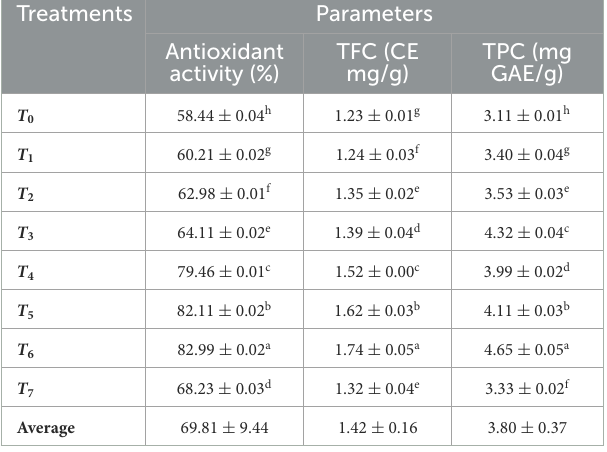
TABLE 6 Effect of adding SPP and MPP on the bioactive profile of Yogurt.